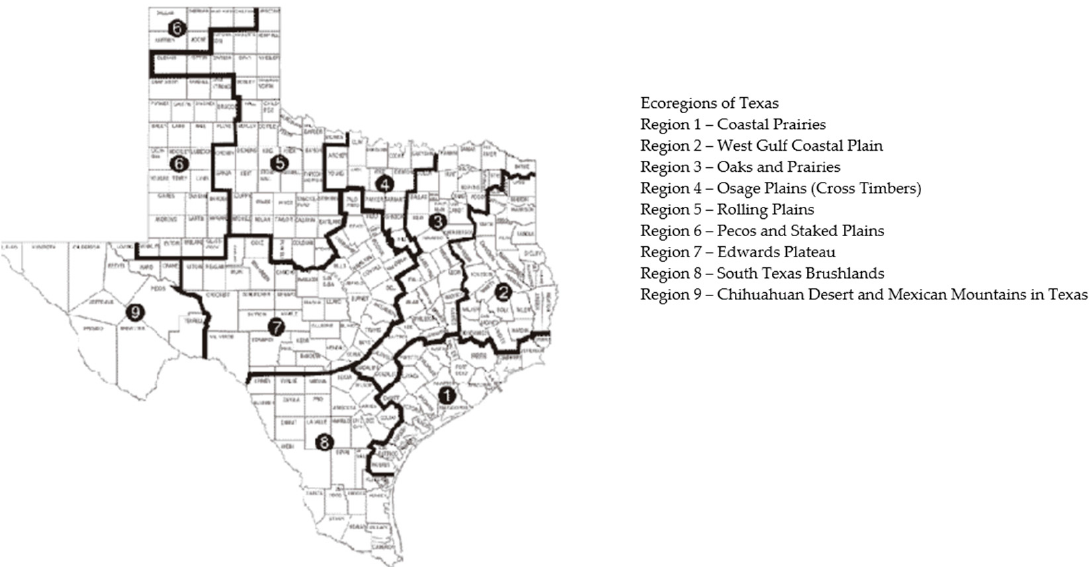
Figure 7. Eco-regions of Texas.